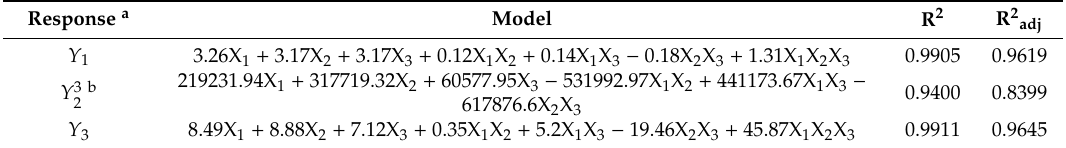
Table 3. Model equations describing response as a function of mixture